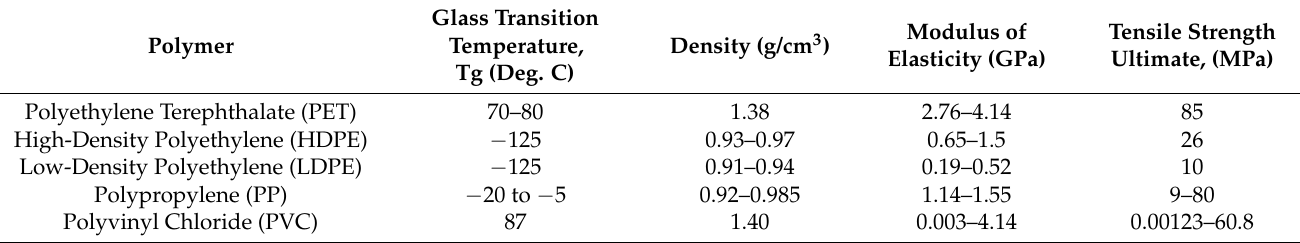
Table 1. Properties of polymers typically used in geogrid materials